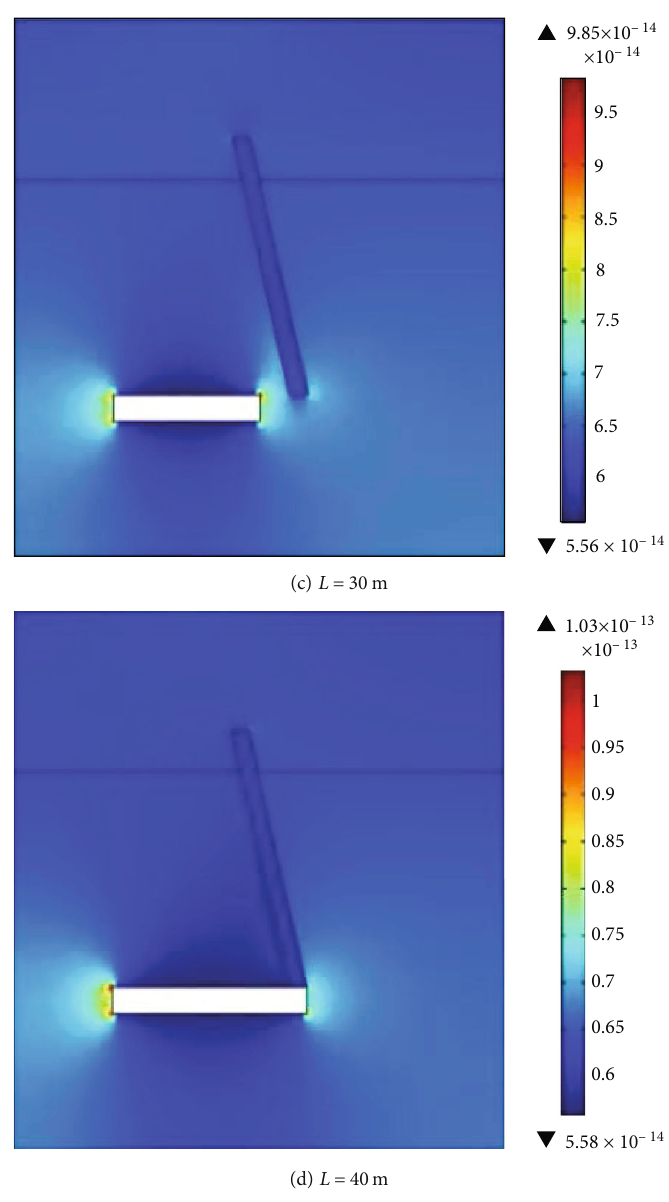
Figure 7: The permeability of isolated cement rock varies with excavation